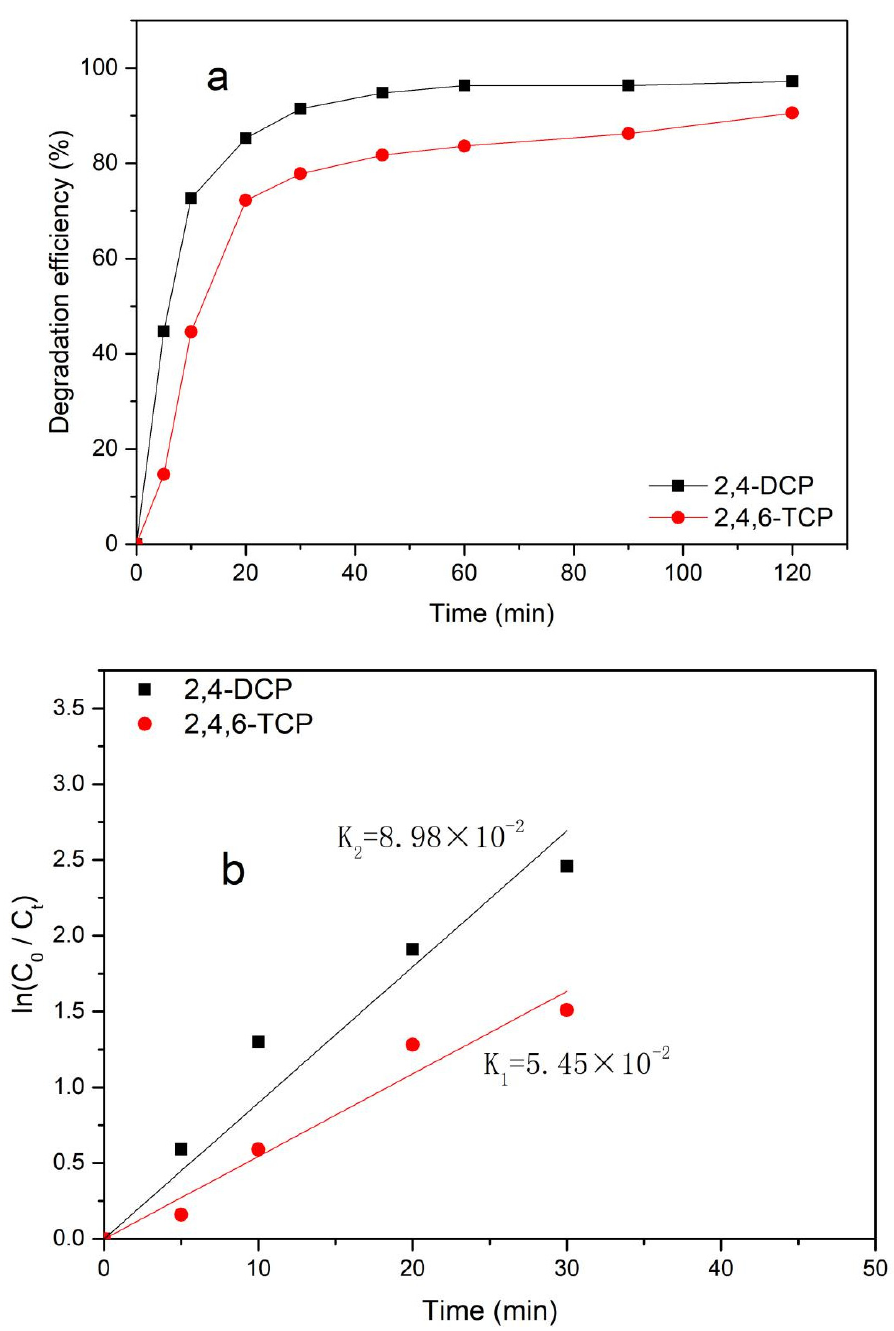
Figure 3. ( a ) EDDS-modified photo-Fenton degradation of 2,4-DCP and 2,4,6-TCP. ( b ) Variation of ln C/C 0 with time in 2,4-DCP and 2,4,6-TCP concentration using the EDDS-modified photo-Fenton system. [2,4-DCP] = [2,4,6-TCP] = 20 mg L − 1 , [Fe(III)-EDDS] = 0.1 mM, [H 2 O 2 ] = 1.0 mM, pH = 7.0 ± 0.1. This difference in 2,4-DCP and 2,4,6-TCP degradation rates could be attributed to the number of chlorine atoms on these CPs, possibly because the OH and Cl groups of 2,4- DCP are aligned along the ortho and para directions, and the •OH radicals have the same